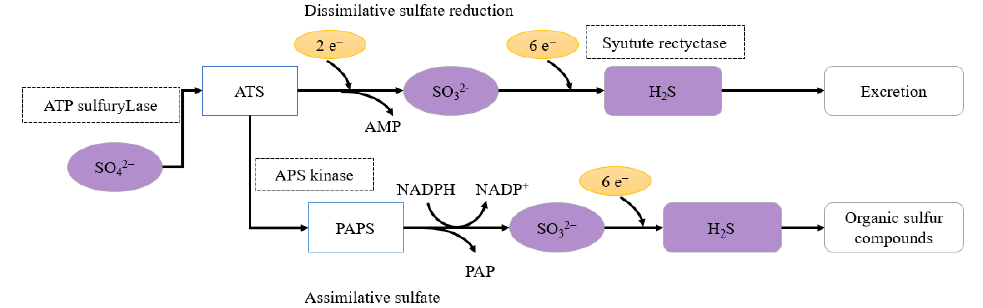
Figure 2. Metabolic reaction process of sulfate-reducing bacteria.